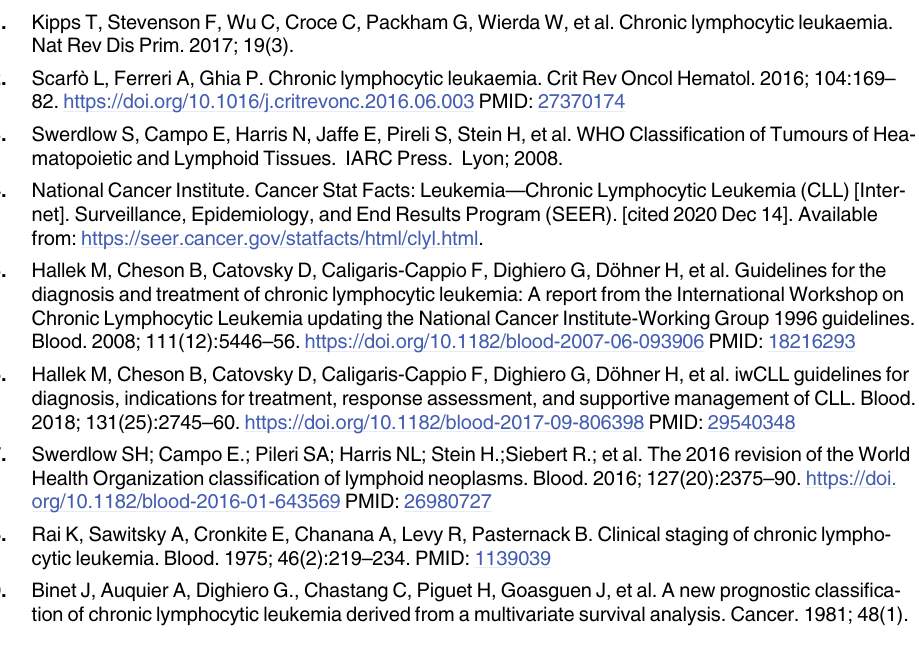
S2 Fig. Kaplan-Meier estimate stratified per Binet stage. (TIF) S1 Table. Second malignancies occurred in CLL patients. CLL, Chronic lymphocytic leukae- mia; CNS, Central nervous system; GIST, Gastrointestinal stromal tumour.